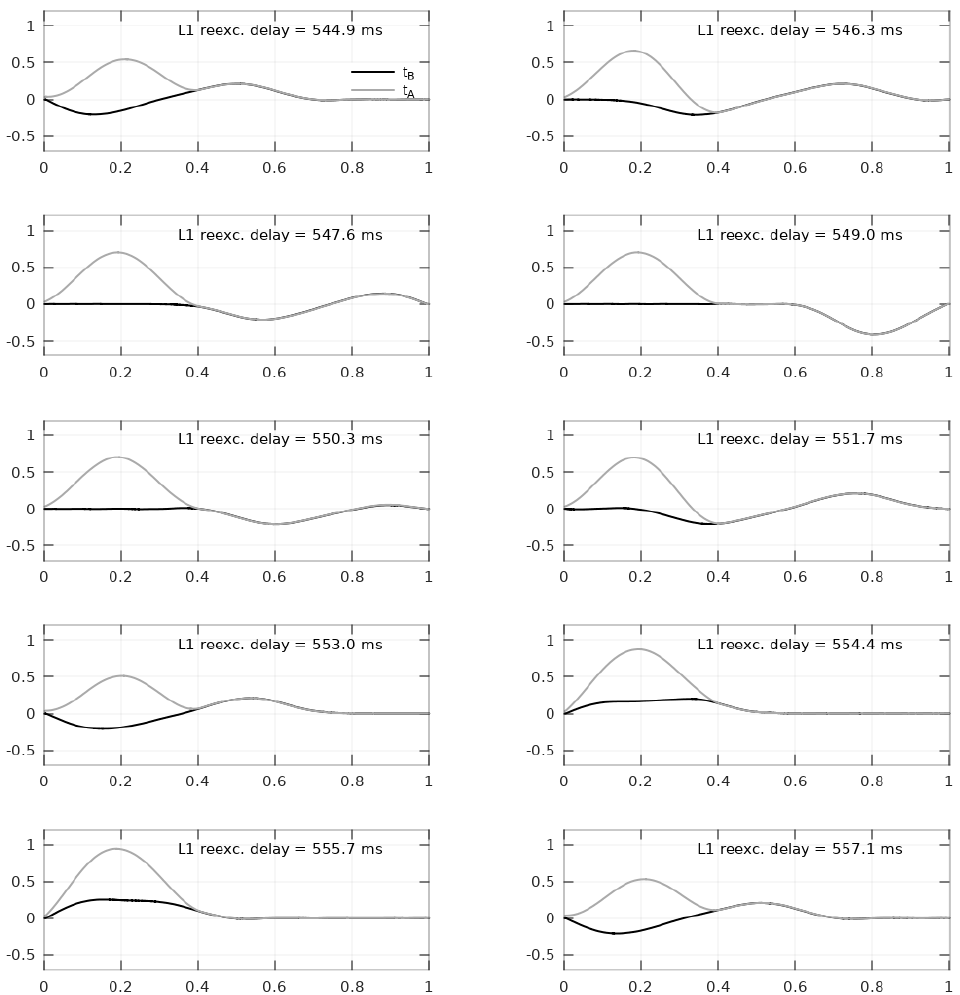
Figure 5. Simulation L1—visualisation of string displacement u in the last time frame before ( t B —dark plot) and the first time frame after the re-excitation ( t A